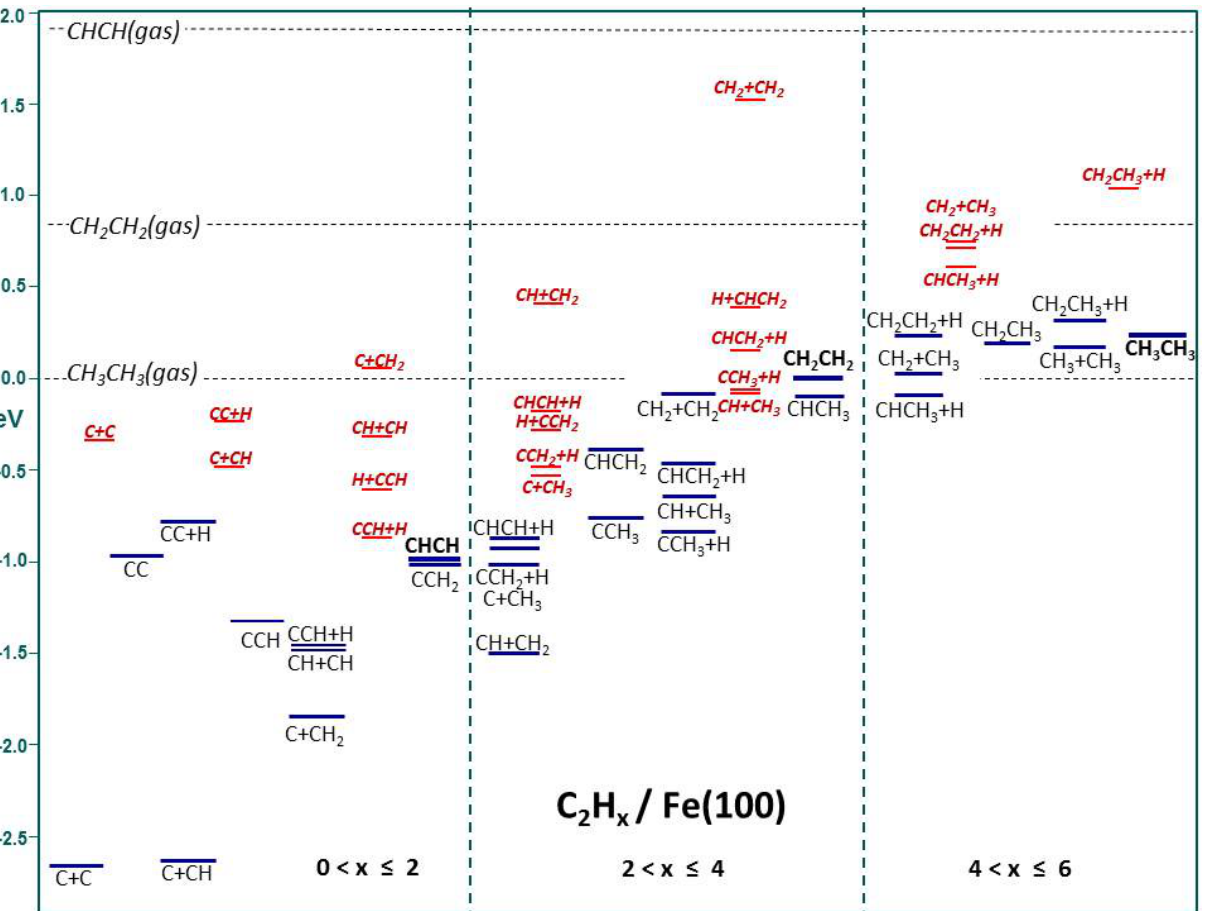
H for x = 0–6; transition states 2 x